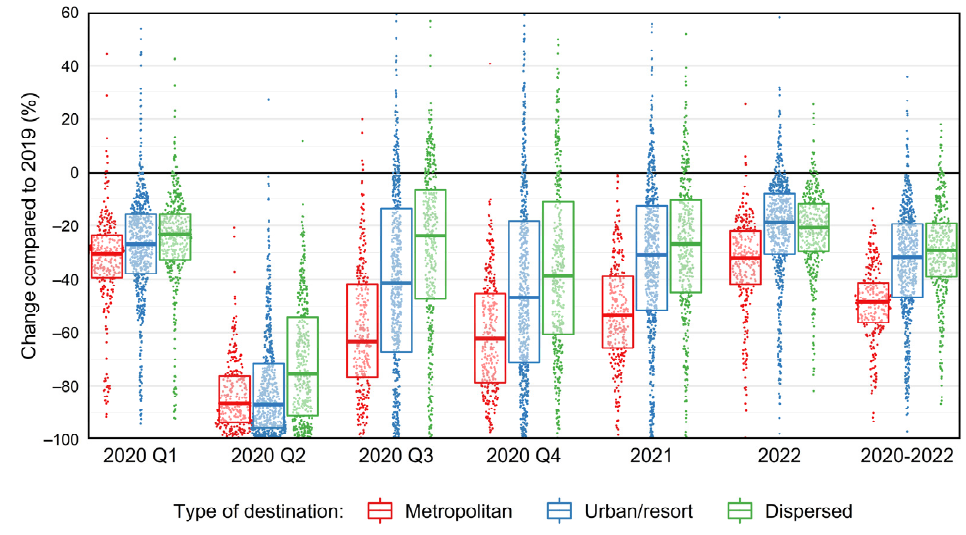
Figure 2. Change in the number of reviews in destinations (box plots show middle quartiles). Table 7. ANOVA of change in the number of reviews in di ff erent types of destinations.